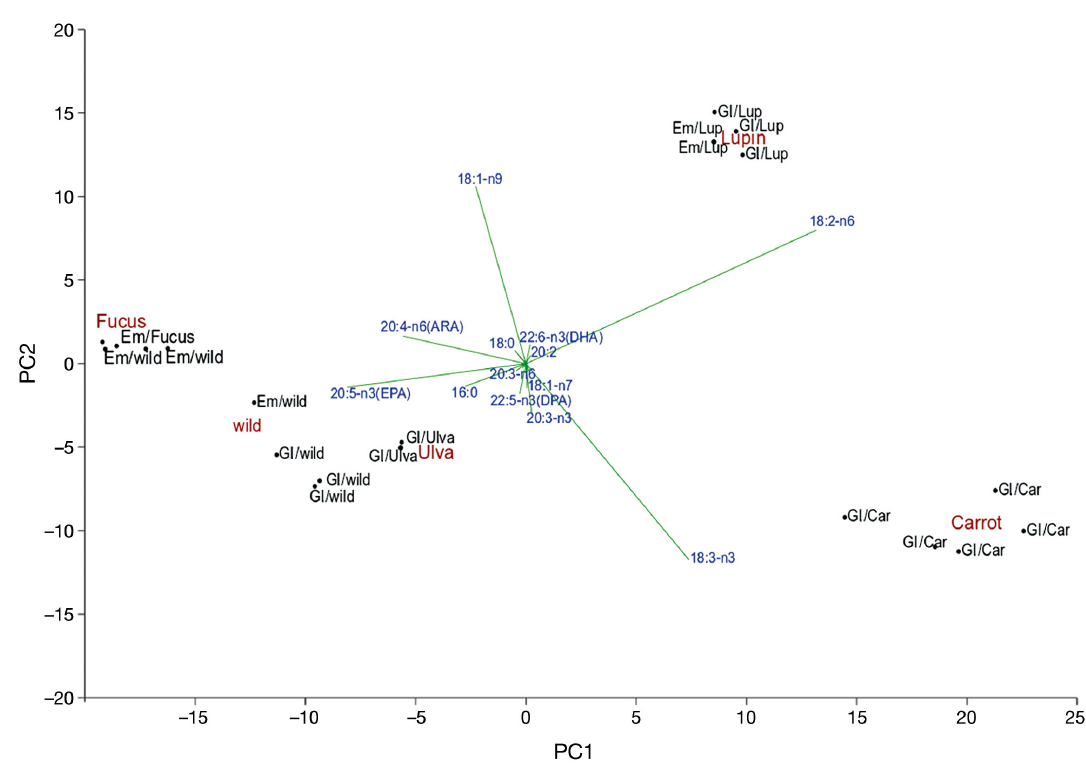
Fig. 2. PCA based on fatty acid composition of Gammarus locusta (Gl) and Echinogammarus marinus (Em) fed different diets ( Ulva , Fucus , lupin meal or carrot leaves) and wild-caught individuals. Only major fatty acids responsible for the grouping pattern are displayed in the